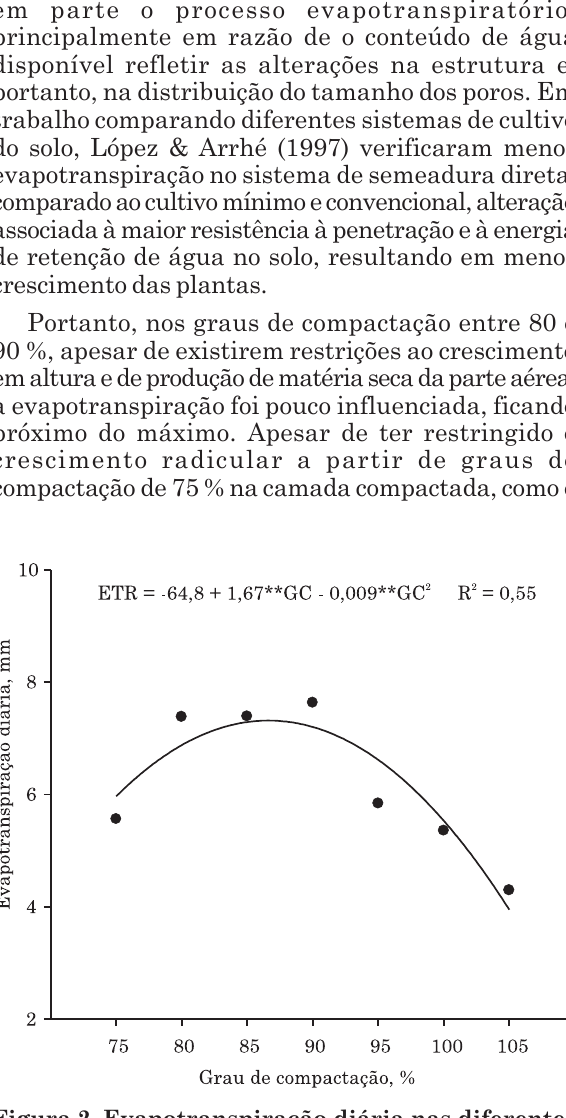
Figura 2. Evapotranspiração diária nas diferentes densidades num Latossolo Bruno. * e **: significativos a 5 e 1 %,